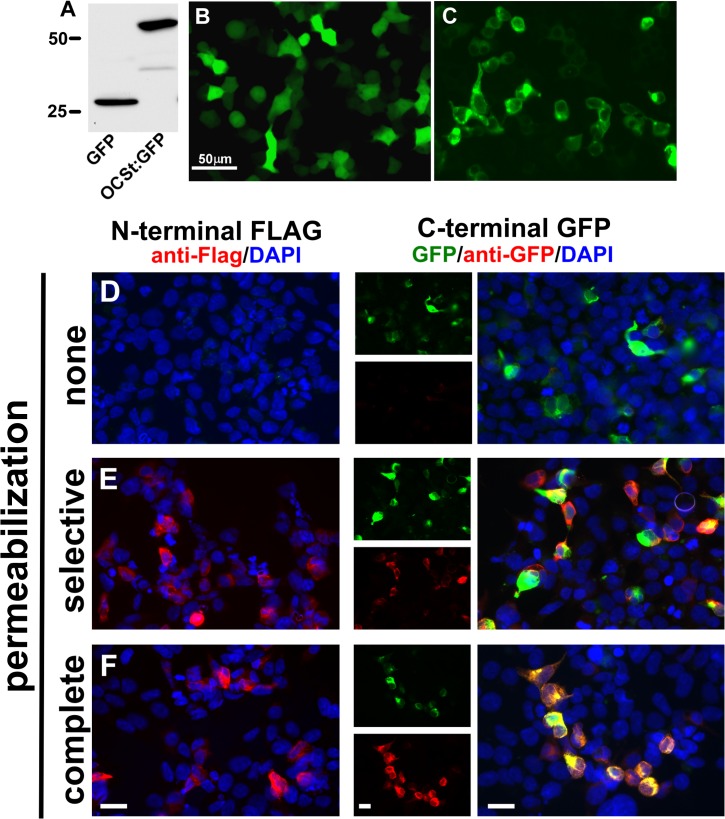
Peripheral localization of OC-STAMP and topology of N- and C-termini.
A-C. HEK293T cells were transfected with either GFP or OC-STAMP-GFP vectors (OCSt:GFP). A. Western blot with anti-GFP antibody shows expected molecular weights (marker positions indicated at left). B and C, GFP fluorescence. In B, endogenous GFP fluorescence is seen throughout the cell, as expected for a cytoplasmic protein. In C, OC-STAMP-GFP signal is mainly confined to the cell periphery, as expected for a plasma membrane-localized transmembrane protein. Scale bar = 50μm. D-F. HEK 293 cells were transfected with tagged constructs indicated at top, permeabilized as indicated at left (none, plasma membrane selectively with digitonin, or all membranes with Triton X-100), and probed with anti-tag antibodies. With membranes intact, anti-FLAG antibody could not access the N-terminus, nor could anti-GFP access the C-terminus, whereas both antibodies could access their antigens when the plasma membrane or all membranes were permeabilized. For the GFP tag, separate green and red channels are also shown in small panels. GFP endogenous signal (green) vs. that for anti-GFP (red) varied in intensity in some cells, but the same cells were positive for both. Scale bars = 10 μm.